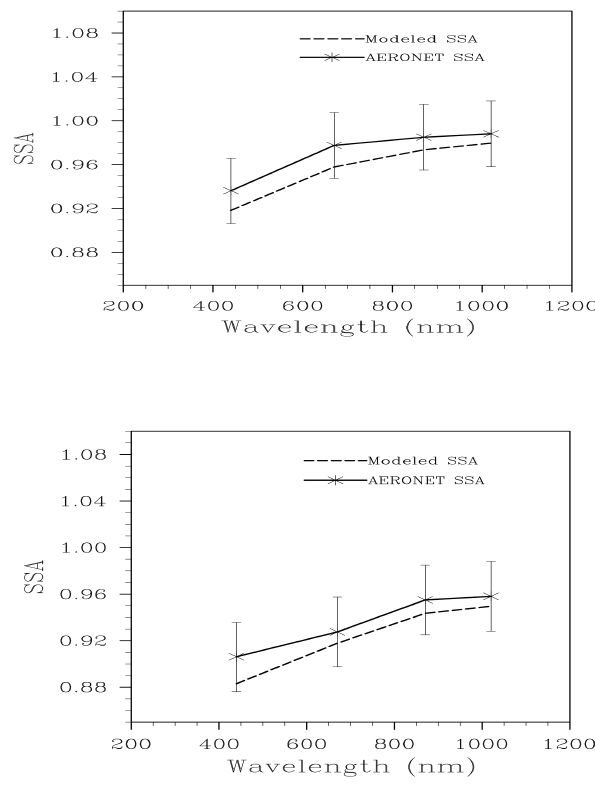
Fig. 18. The comparison of the single scattering albedo between the model simulations and the AERONET retrievals both for Asia Deserts (top) (Dalanzadgad (43.3 ◦ N, 104.3 ◦ E) in April 2006) and Sahara Deserts (bottom) (Tamanrasset TMP (22.5 ◦ N, 5.3 ◦ E) in July